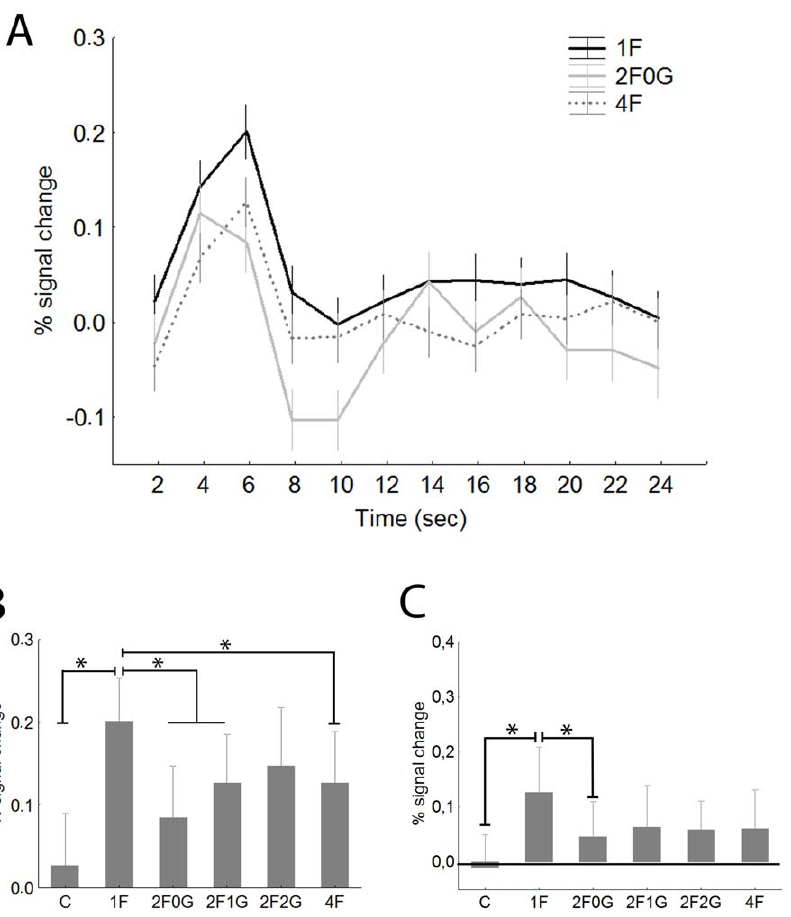
Figure 2. The right FFA. A Time course (mean 6 standard error) of fMRI activity for contralateral visual presentations. For sake of clarity only the 1F (black), 2F0G (gray) and 4F (dashed) conditions are depicted. Data derived from a finite impulse response (FIR) model with 2 s time bins. B. Average peak (4 2 6 sec) activation profiles ( 6 standard error) of the right FFA for the six experimental conditions for contralateral stimulation. C. Average peak activation profiles ( 6 standard error) of the right FFA for ipsilateral stimulation. C- control, noise images, 1F-single face, 2F0G- two neighbouring face images and two noise images, 2F1G- two faces with one noise image in between them, 2F2G- two faces, separated by two noise images, 4F- four face images. * - Fishers post-hoc comparisons: p , 0.05.